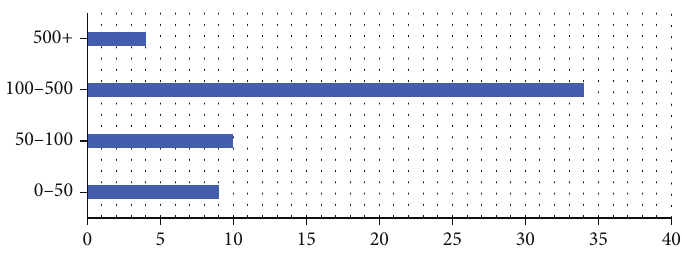
Figure 9: No. of papers as per sample